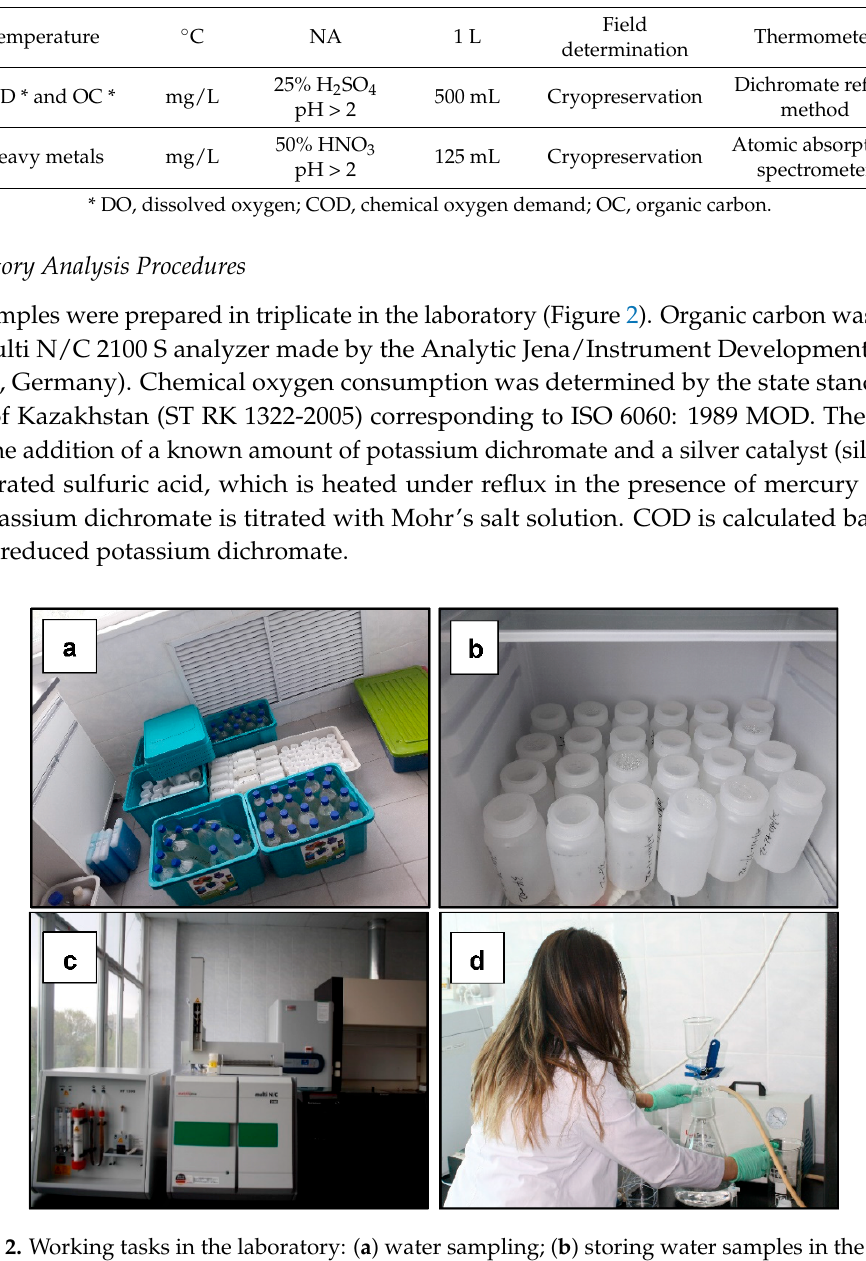
Figure 2. Working tasks in the laboratory: ( a ) water sampling; ( b ) storing water samples in the fridge; and ( c , d ) obtaining physicochemical water properties.